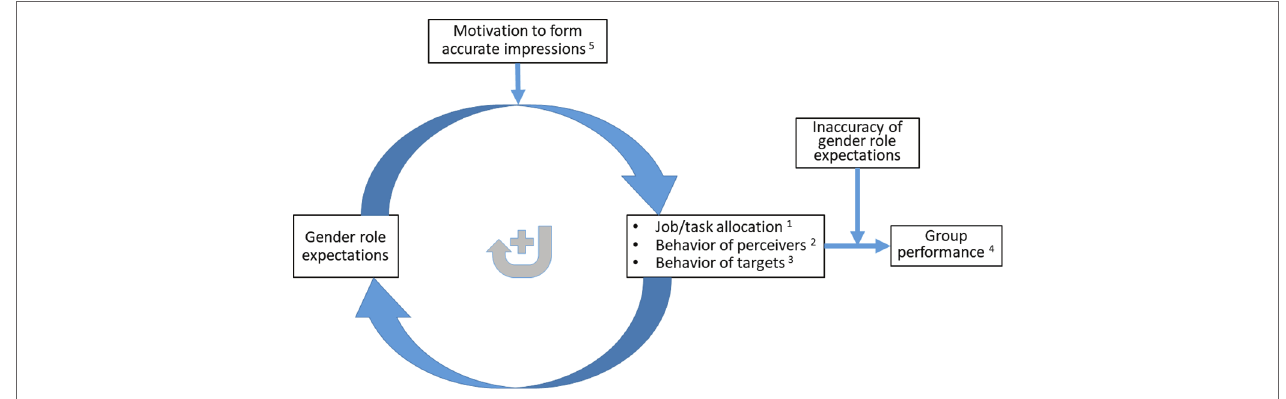
FIGURE 1 | The flywheel of gender role expectations, group performance, and impression formation motivation. Note : numbers indicate the corresponding